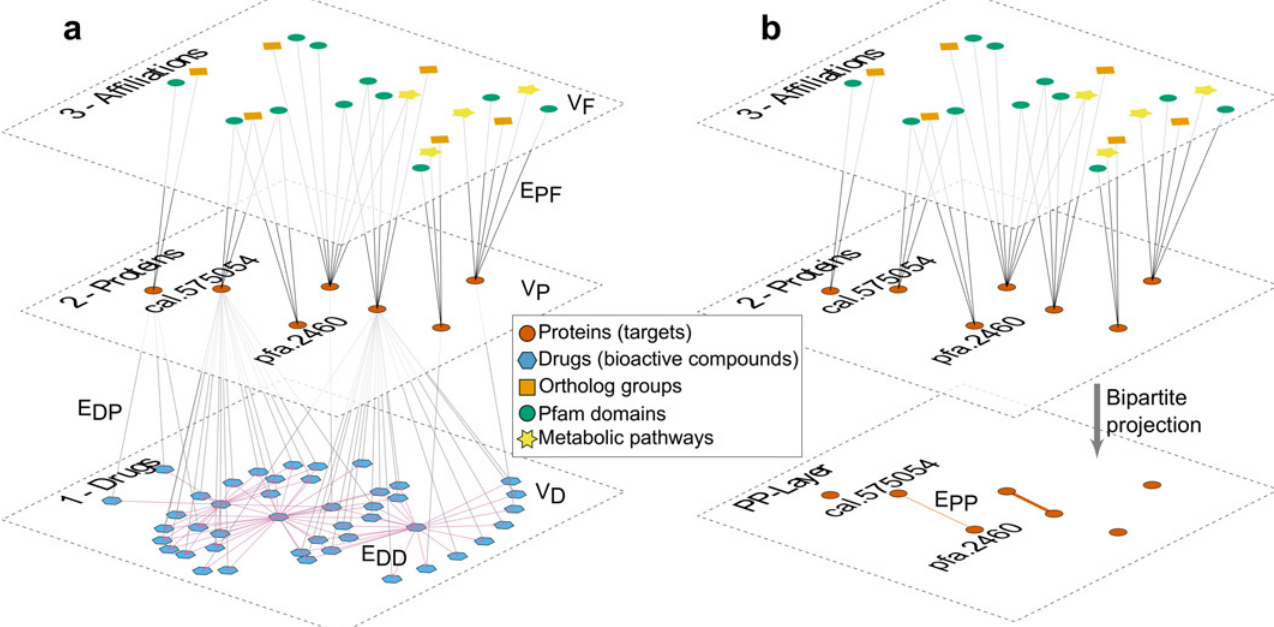
Fig 1. Schematic representation of data and workflow. a) Multilayer representation of drug-target data. First layer (bottom) contains drugs as nodes and chemical similarity relations as edges. Second layer contains proteins as nodes. Links between these two layers represent known and significant bioactivity of a compound against a defined protein target. The top layer contains functional annotation-type objects as nodes (Pfam domains, green circles; Ortholog groups, orange diamonds; and metabolic pathways, yellow stars). Links between the second and third layers represent affiliations of proteins to each of these annotation classes. For clarituy, the representation shows a partial view of the whole network corresponding to objects and connections related to the example shown in Fig 5. b) Bipartite projection of the two upper layers, into a protein-protein monopartite network after weighting of informative affiliations as described in the main